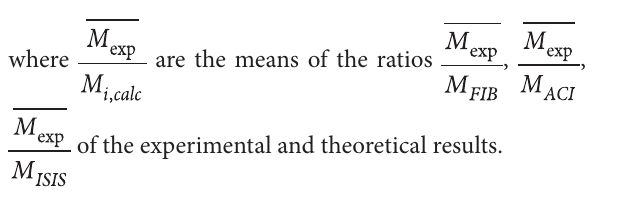
Table 2. Sample statistics and results of Shapiro-Wilk test